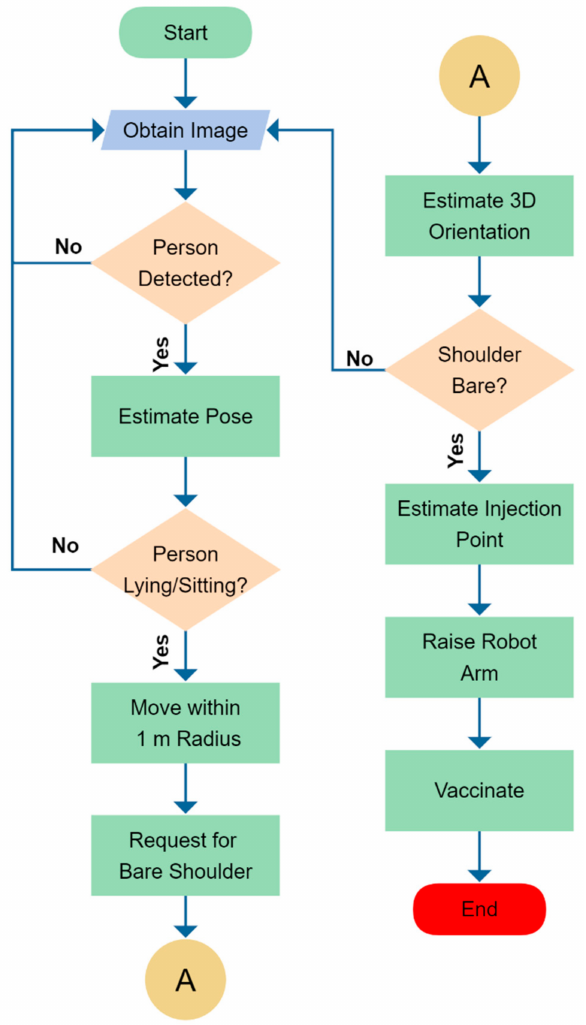
Figure 9. Algorithm for autonomous vaccination.